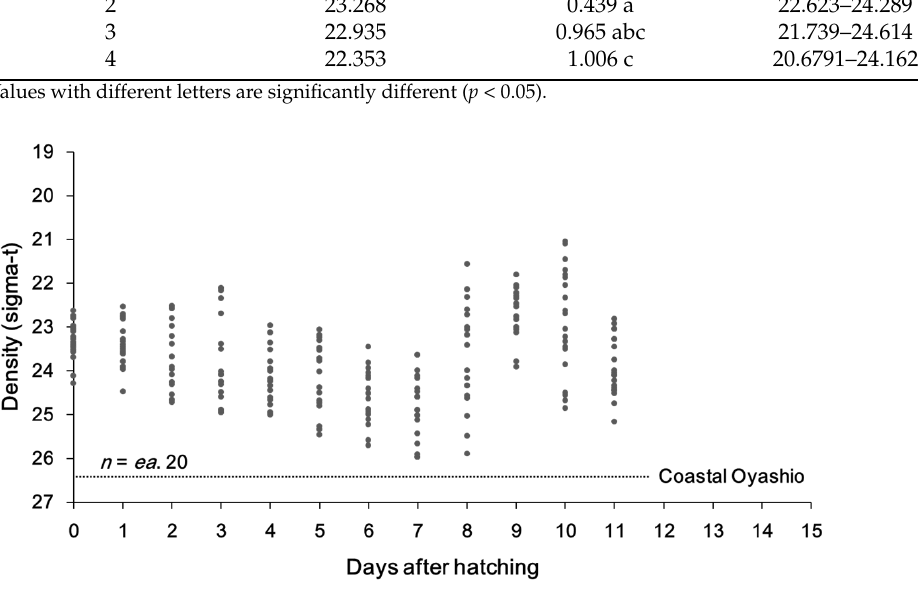
Figure 3. Change in specific density of walleye pollock larvae; n = 20. (NB: This experiment was incomplete as sufficient larvae were unavailable.) The horizontal line shows the density of the coastal Oyashio water ( σ t 26.4).